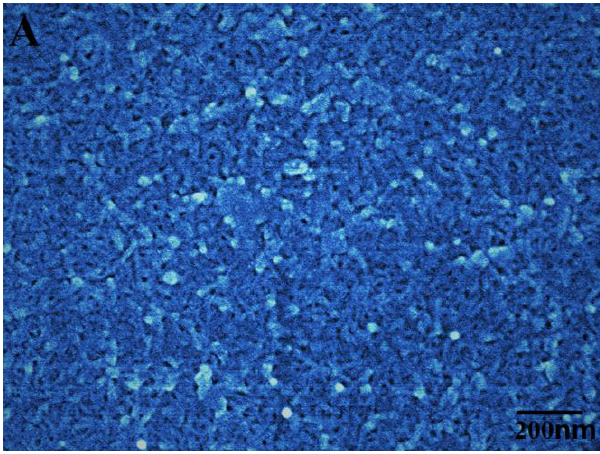
Figure 5. Section electron micrograph of 0.2% acid coating.